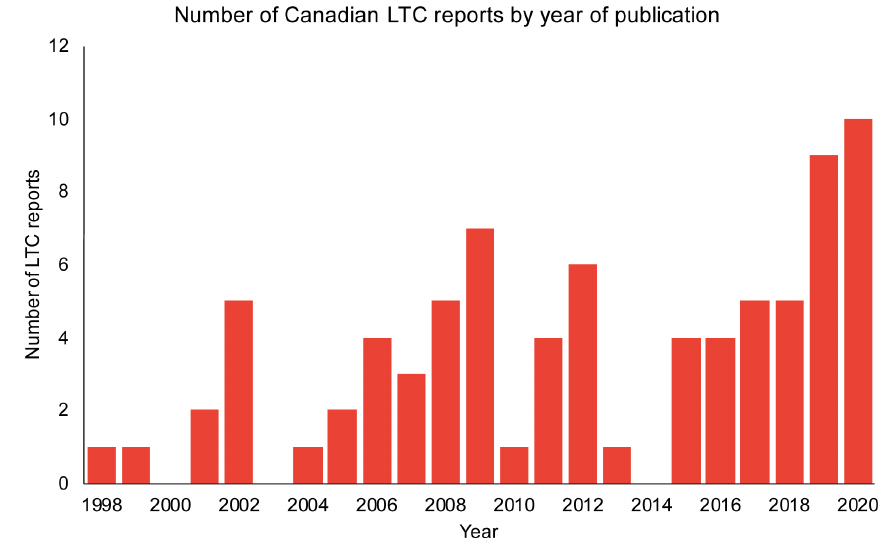
Figure 1. The number of Canadian reports with long-term care (LTC) recommendations over the span of